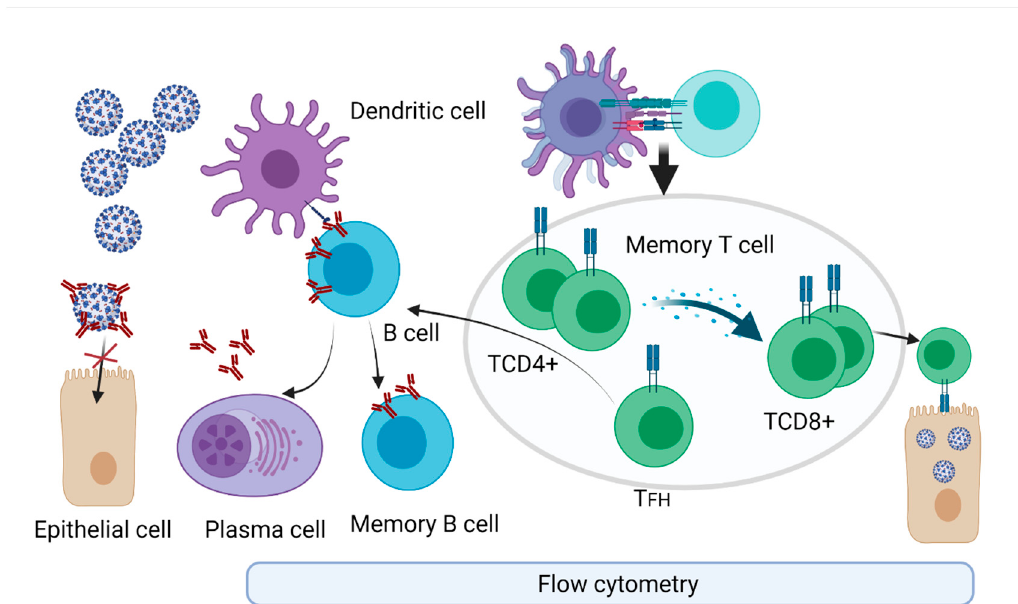
Figure 3. Cellular immune response upon infection detected using flow cytometry. Activated DCs present antigen and co-stimulatory molecules to specific naïve T cells, which become activated and further differentiate into effector cells (T CD8+ cytotoxic cells), T helper cells (CD4+). Activated DCs can directly activate specific B cells and induce B cell differentiation. T follicular helper (TFH) cells help B cells to differentiate into plasma cells that secrete specific antibodies and further generate B memory cells. Generated antibodies physically hinder the entrance of new viral particles into cells. Memory T cells are generated to sustain the long-time cellular immune memory, and CD4+ T cells memory cells secrete cytokines that induce the cytotoxic activity of T cells CD8+ that attack infected cells, stopping the further viral reproduction. T and B memory cells sustain long-lasting memory of the infection, and upon a second encounter with the same virus, quickly trigger all the necessary immune pathways. Created with BioRender.com.(access on 15 September 2021)